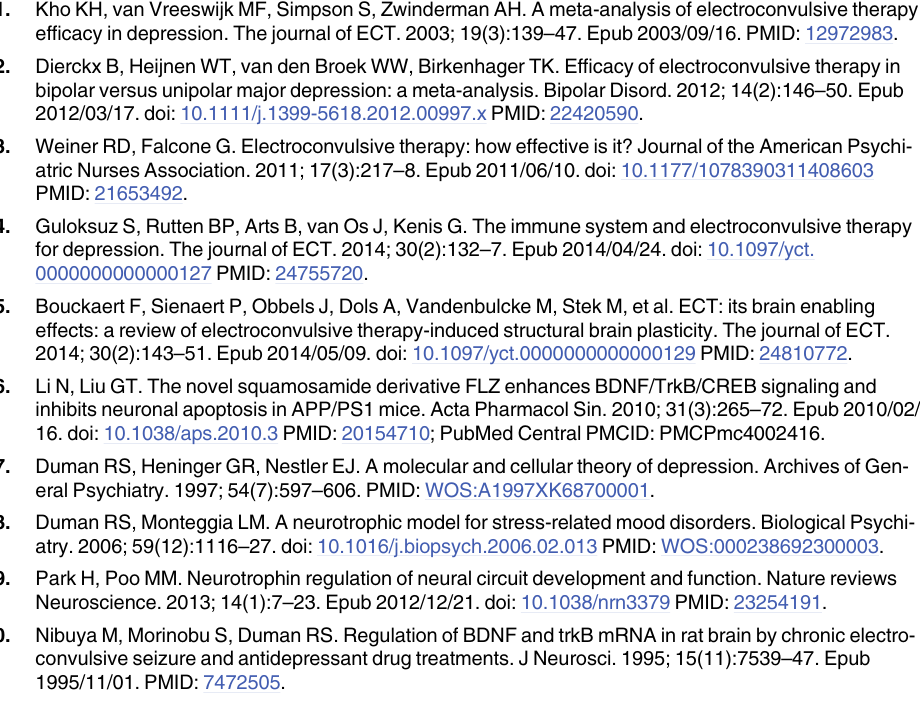
S4 Table. Brain regions in which BDNF was sampled in the preclinical studies that we included. S5 Table. Basic information on the animals that were used in the preclinical studies that were included in our meta-analysis. S6 Table. Basic methodological information on the preclinical studies that were included in our meta-analysis. S7 Table. Basic information on the patients that were included in the clinical studies that were included in our meta-analysis. S8 Table. PRISMA checklist. S1 Text. Quality assessment of the included